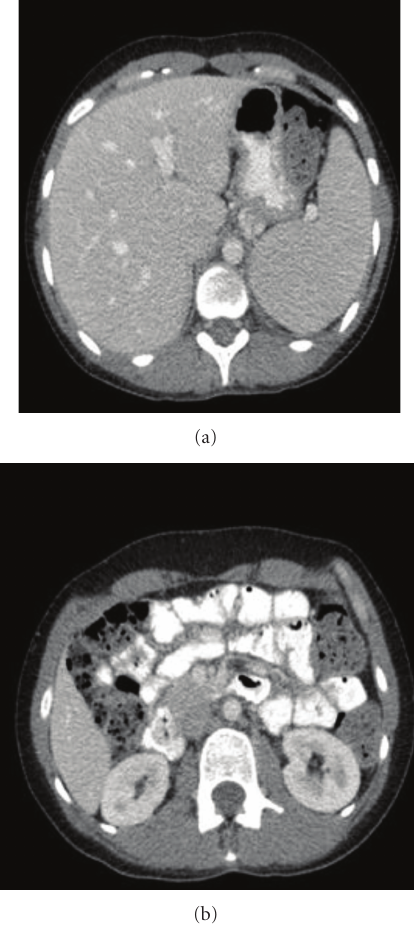
Figure 6: Computed tomography showing resolution of ascites and small bowel thickening three months after discharge from